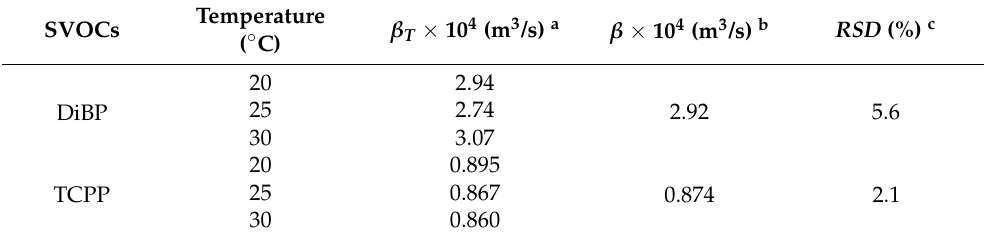
Table 2. SPME calibration constants ( β ) of DiBP and TCPP measured at different temperatures.